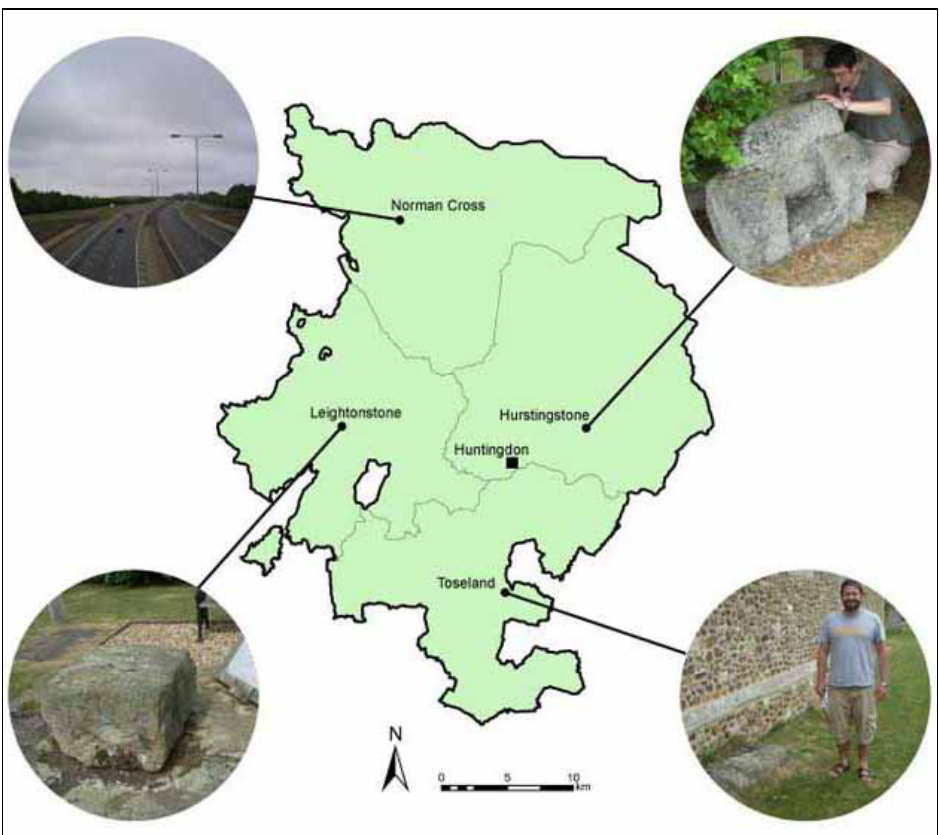
Fig. 6: The Domesday geography of Huntingdonshire shows a remarkably uniform pattern of hundreds arranged around the burh of Huntingdon, with each hundred being named after a distinctive stone or cross: Toseland (perhaps remembering a Danish earl, Tog- los, who is mentioned in the Anglo-Saxon Chronicle as having died in the battle of Tempsford in 921); Leightonstone (‘leek-enclosure/herb-garden stone’); Hursting- stone (‘wooded-hill dweller’s stone’); and